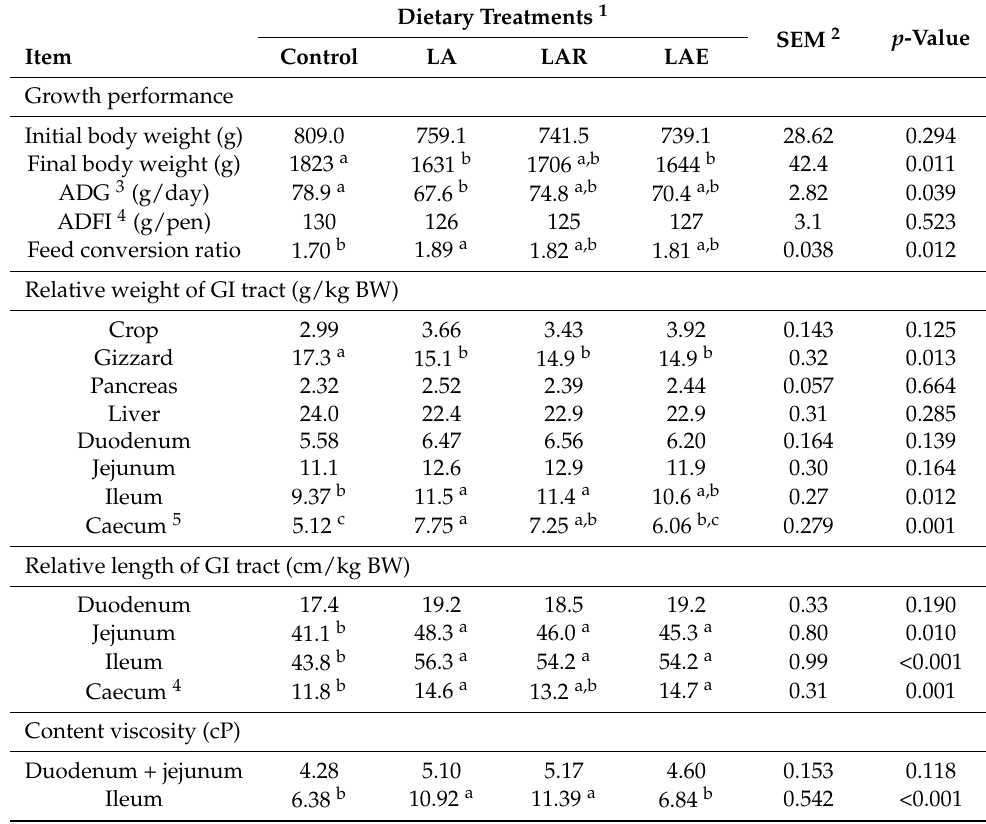
Table 3. Growth performance (day 21–day 35), relative weight and length of gastrointestinal (GI) tract, and intestinal content viscosity of broilers ( n = 10).